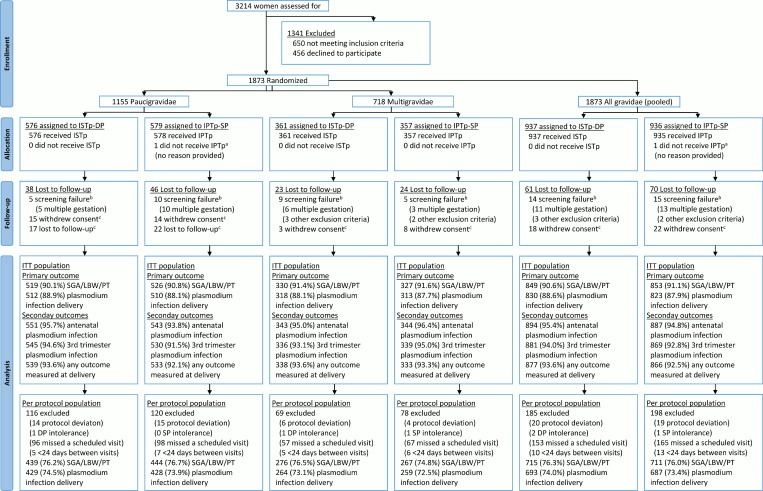
Flow chart.
aOne woman randomized to IPTp-SP was erroneously recorded as being in the ISTp-DP arm on her antenatal care card and as a result received ISTp-DP. She was included in the ITT population under the IPTp-SP arm. bScreening failures were not followed to delivery and were excluded from the modified ITT population. cWomen lost to follow-up prior to delivery and women who withdrew consent were included in the ITT population and contributed to the antenatal follow-up analyses (e.g., incidence of malaria). IPTp-SP, intermittent preventive therapy in pregnancy with sulfadoxine-pyrimethamine; ISTp-DP, intermittent screening and treatment in pregnancy with dihydroartemisinin-piperaquine; ITT, intention to treat; SGA/LBW/PT, small for gestational age or low birthweight or preterm.